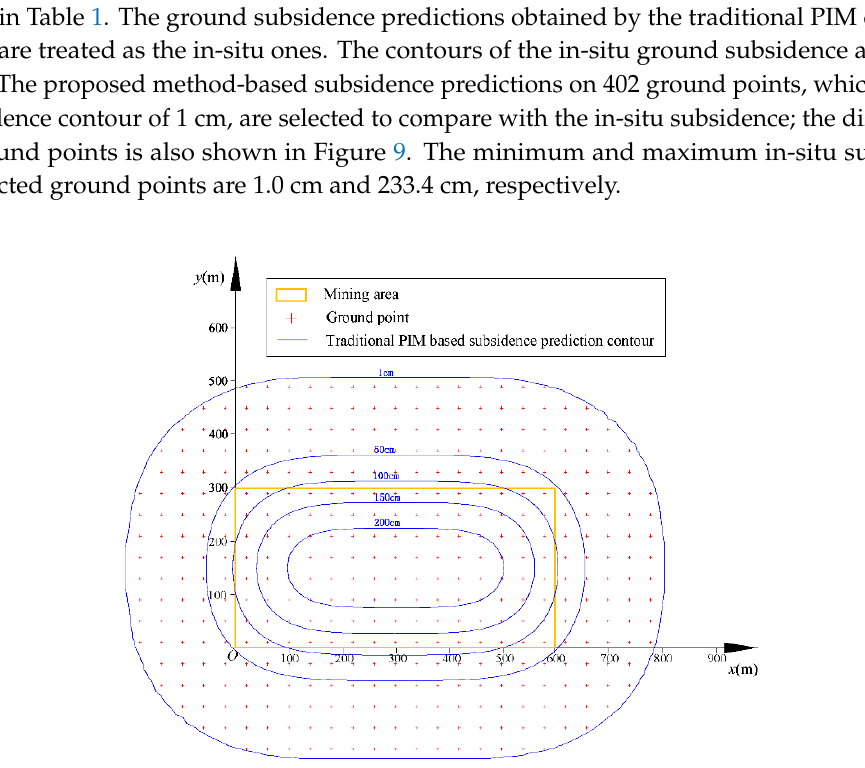
Figure 9. Simulated mining area and traditional PIM predicted subsidence contours. Table 1. PIM parameters and simulated mining area parameters.